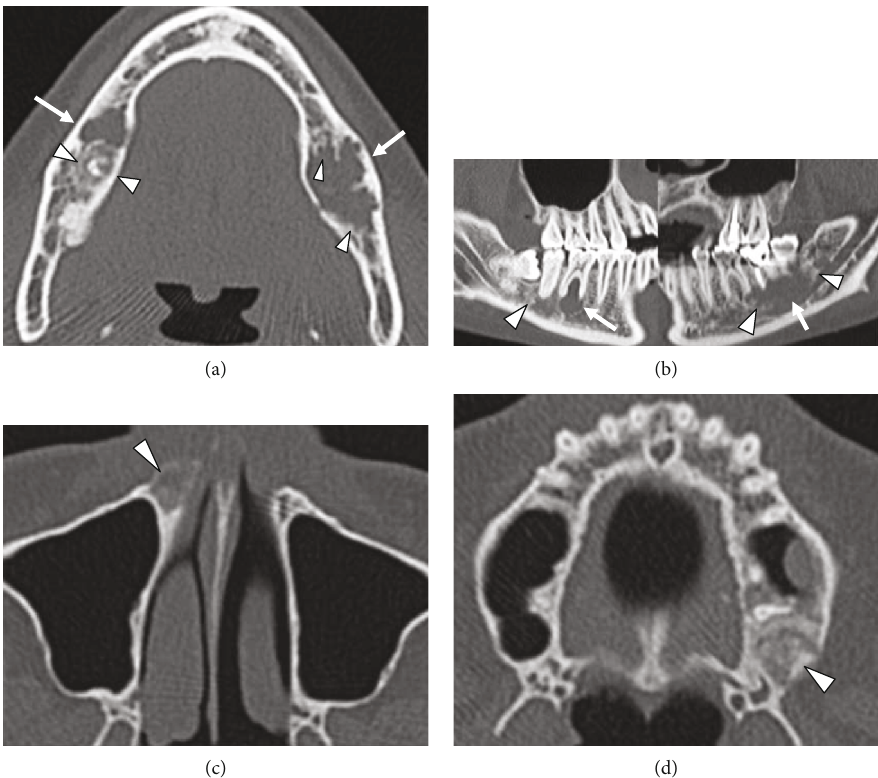
Figure 2: CT images. (a, b) Well-de fi ned, low-density lesions ( arrows ) with scalloped border, which accompanies a well-de fi ned high-density appearance ( arrowheads ) are observed in the right mandibular molars on transverse and sagittal images. The left lesion shows mixed main low- ( arrows ) and partial high- ( arrowheads ) density areas with an unusual, marked irregular border in the molar region. The right lesion shows a unilocular, slightly irregular border. (c, d) Transverse CT images show high-density lesions in the right anterior and left posterior maxilla ( arrowheads ). CT: computed